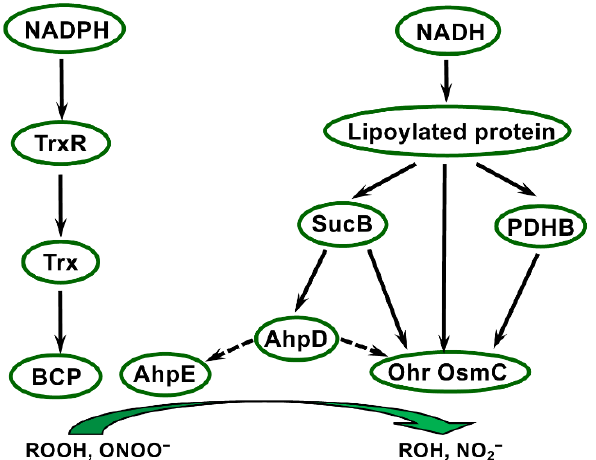
Figure 3. Electron sources for Deinococcus NADPH- and NADH-dependent thiol peroxidases (BCP, AhpE, AhpD, Ohr, OsmC) scavenging hydrogen and organic peroxides and peroxynitrites and participating in redox signalling. TrxR, thioredoxin reductase; Trx, thioredoxin; BCP, bacterioferritin comigratory protein; SucB, dihydrolipoamide succinyltransferase; PDHB, pyruvate dehydrogenase beta; Ahp, alkyl hydroperoxide reductase; Ohr, organic hydroperoxide resistance enzyme; OsmC, osmotically induced bacterial protein C. Dashed arrows indicate possible transfer of electrons.